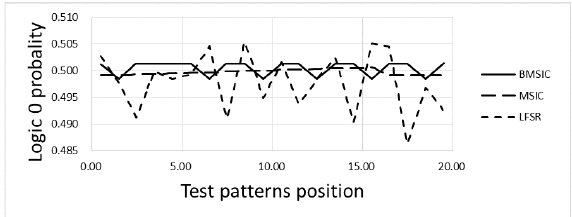
Figure 6. Test pattern direction Logic “0” Probability